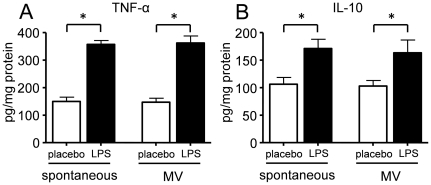
Effects of ventilation with 8 mL/kg in LPS- or placebo-pretreated rats on pulmonary inflammation.Pulmonary concentrations of pro-(A: TNF-α) and anti-inflammatory (B: IL-10) cytokines in placebo- and LPS-treated spontaneously breathing and mechanically ventilated (MV, 8 mL/kg) rats. Pulmonary cytokine levels are normalized to the total amount of protein in each lung homogenate. Data are represented as mean ± SEM of 8–9 animals per group. * indicates p<0.05, one-way ANOVA with Bonferroni post-hoc test.